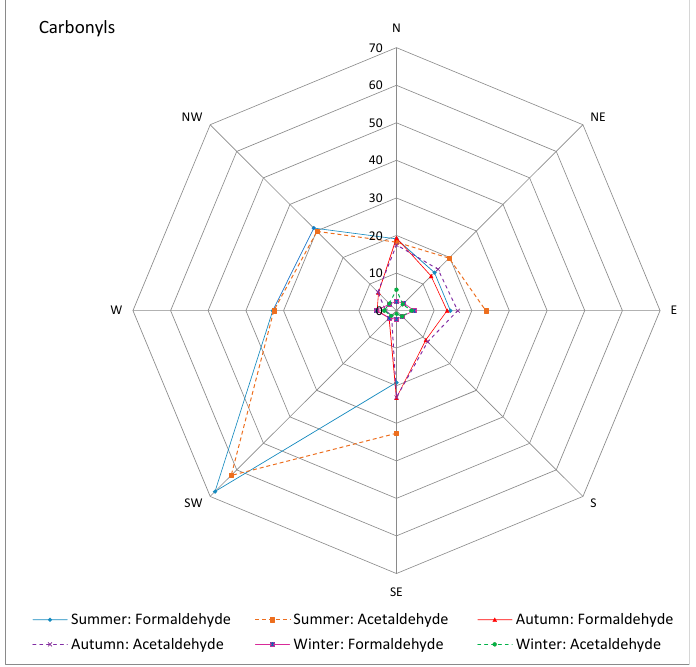
Figure 5. Carbonyl concentration and wind direction diagrams (µg m − 3 ).